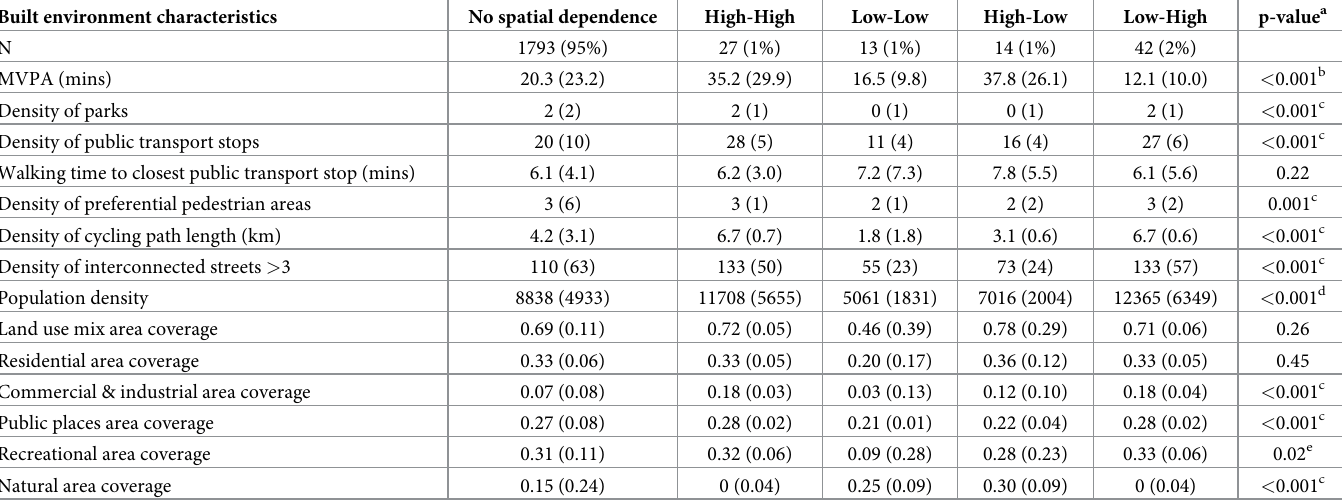
Table 1. Built environment characteristics in raw MVPA spatial clusters.